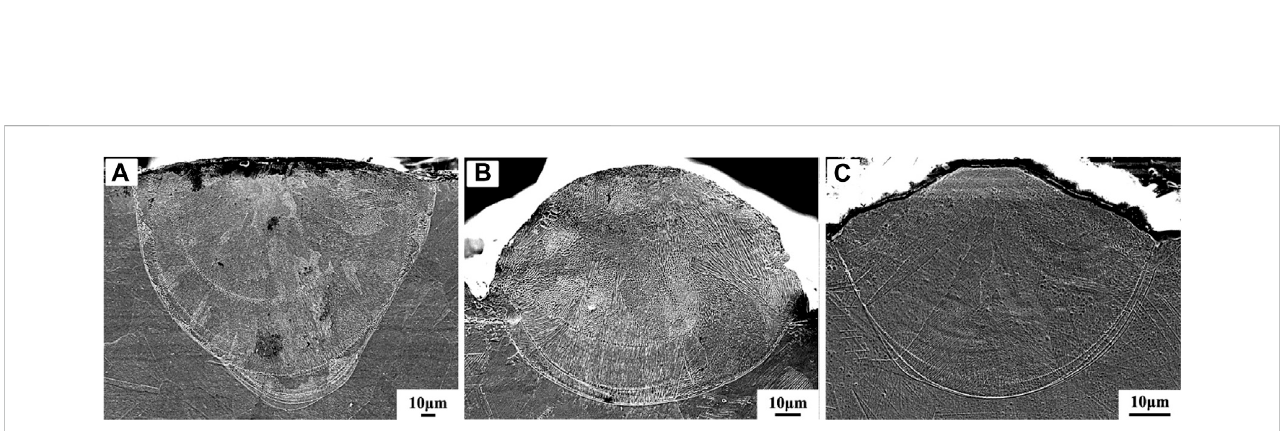
FIGURE 7 TheeffectofLEDonmicrostructure: (A) P=160 W,V=300 mm/s,LED=272 J/mm 3 , (B) P=100 W,V=200 mm/s,LED=255 J/mm 3 , (C) P=130 W,V= 900 mm/s, LED = 74 J/mm 3